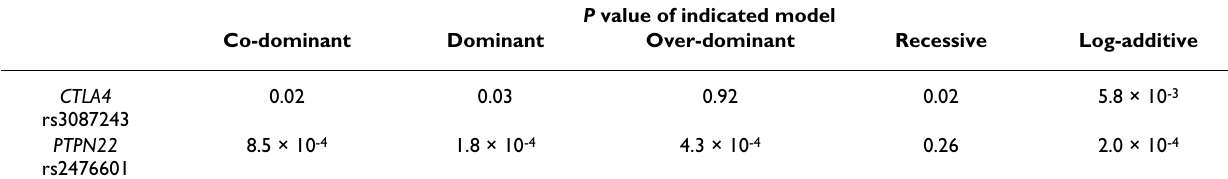
Table 4: Models of inheritance for the CTLA4 rs3087243 and PTPN22 rs2476601 associations in AAV P value of indicated model Co-dominant Dominant